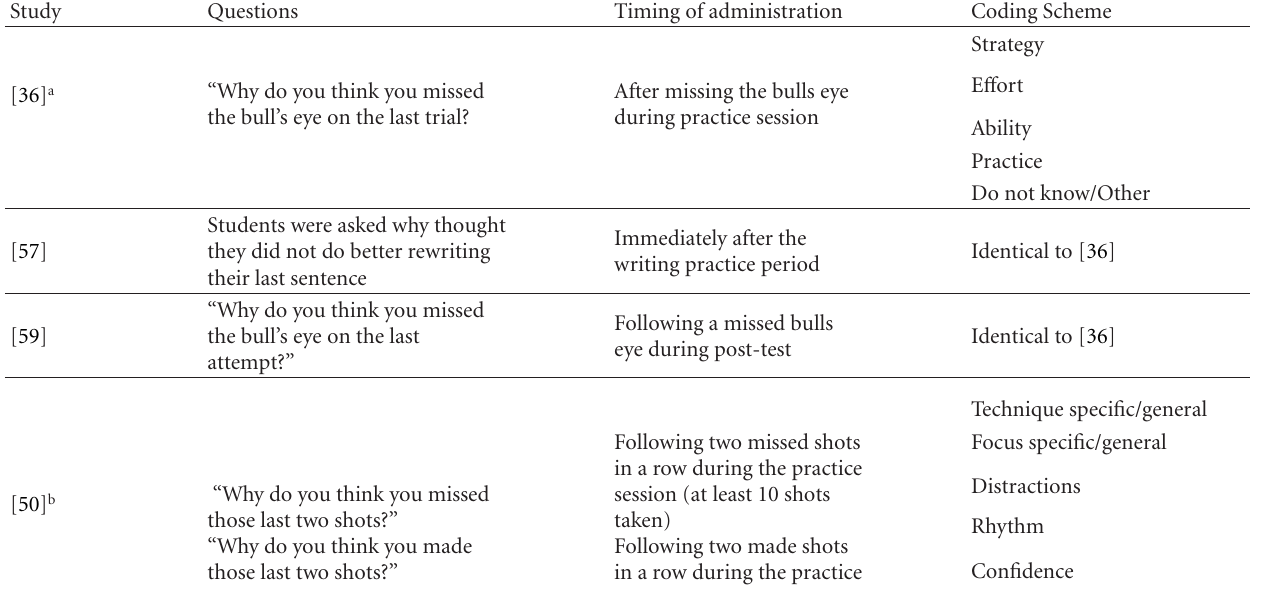
Table 6: Examples of attribution microanalytic questions, administration sequence, and coding